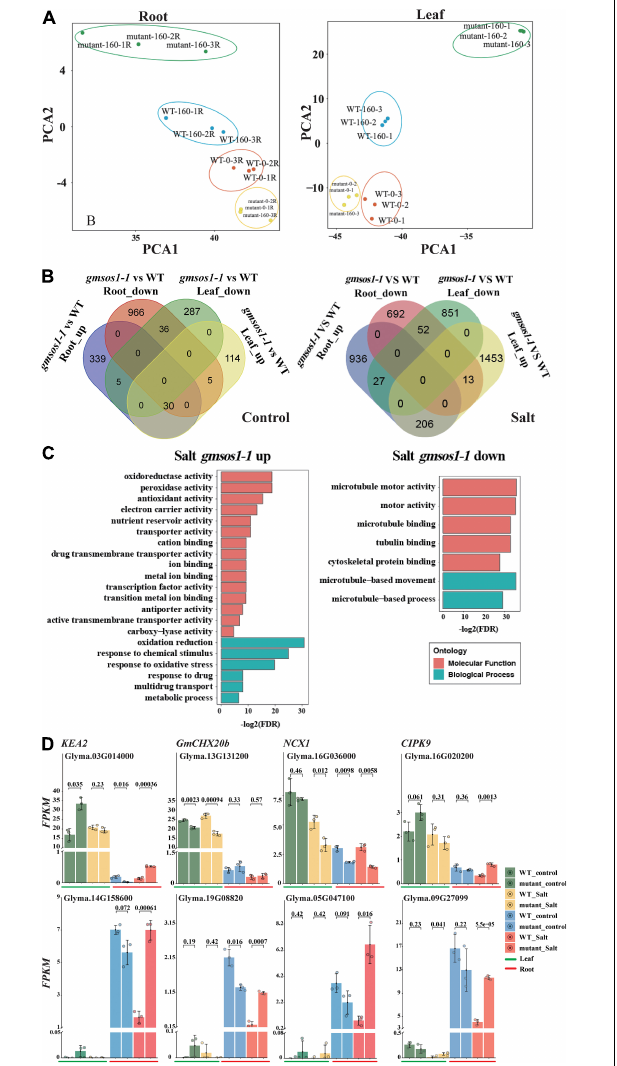
FIGURE 5 | Summary of differentially expressed genes (DEGs) in the gmsos1-1 mutant. (A) Principal component analysis of the 2,000 most significant DEGs in root and leaf of the gmsos1-1 and wild-type plants ( n = 3 biological replicates). (B) Four-way Venn diagram indicating the number of upregulated and downregulated genes in the unifoliate leaves and roots of gmsos1-1 mutant under control conditions (left panel). Four-way Venn diagram indicating the number of upregulated and downregulated genes found in the comparison between the roots of gmsos1-1 mutant and wild type under 160 mM NaCl treatment (right panel). (C) Gene-ontology analysis of the upregulated and downregulated genes in salted gmsos1-1 mutant. (D) Fragments per kilobase million (FPKM) of significantly upregulated and downregulated DEGs found in unifoliate leaves and roots of gmsos1-1 mutant and the wild-type W82 under 160 mM NaCl treatment. Error bars indicate standard deviation ( n = 3). P -values are from Student’s t -tests. (GO:0022804, 17 genes; FDR of 0.004) ( Supplementary Table 3 ). The top enriched GO categories of the downregulated DEGs in the salt-treated roots of the gmsos1-1 are microtubule network-related genes (GO:0007018, 20 genes; FDR of 2.10E-11) ( Supplementary Table 2 ). There are 54 DEGs in the